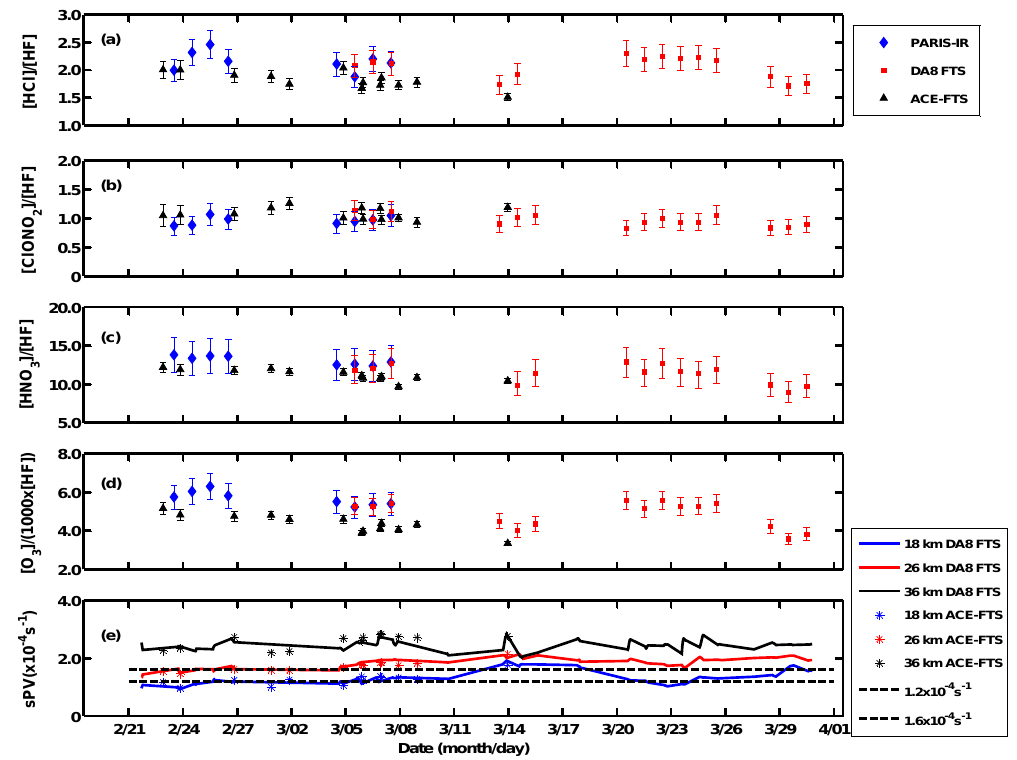
Fig. 7. Time evolution of total column density ratio for HCl (a) , ClONO 2 (b) , HNO 3 (c) , and O 3 (d) , normalized with HF from the observations using PARIS-IR (blue diamonds) and the DA8 FTS (red squares) during the 2006 Canadian Arctic ACE Validation Campaign. The partial column density ratios calculated from the ACE-FTS results are also shown (black triangles). The altitude ranges of the partial column density ratios of [HCl]/[HF], [ClONO 2 ]/[HF], [HNO 3 ]/[HF], and [O 3 ]/[HF] from ACE-FTS are 13.5–44.5km, 14.5–30.5km, 13.5– 31.5km and 13.5–44.5km, respectively. The altitude range of the total column density ratios from the DA8 FTS and PARIS-IR is surface – 100km. (e) The scaled potential vorticity (sPV) at altitudes of 18km, 26km and 36km along the optical paths of the DA8 FTS measurements and those of ACE-FTS from GEOS-4 analyses. The dashed lines indicate 1.2 and 1.6 × 10 − 4 s − 1 , the edges of the polar vortex. Error bars for the ratios are calculated by propagating the error in the total column densities given in Table 2 for the DA8 FTS and PARIS-IR, and the spectral fitting error for the ACE-FTS partial column